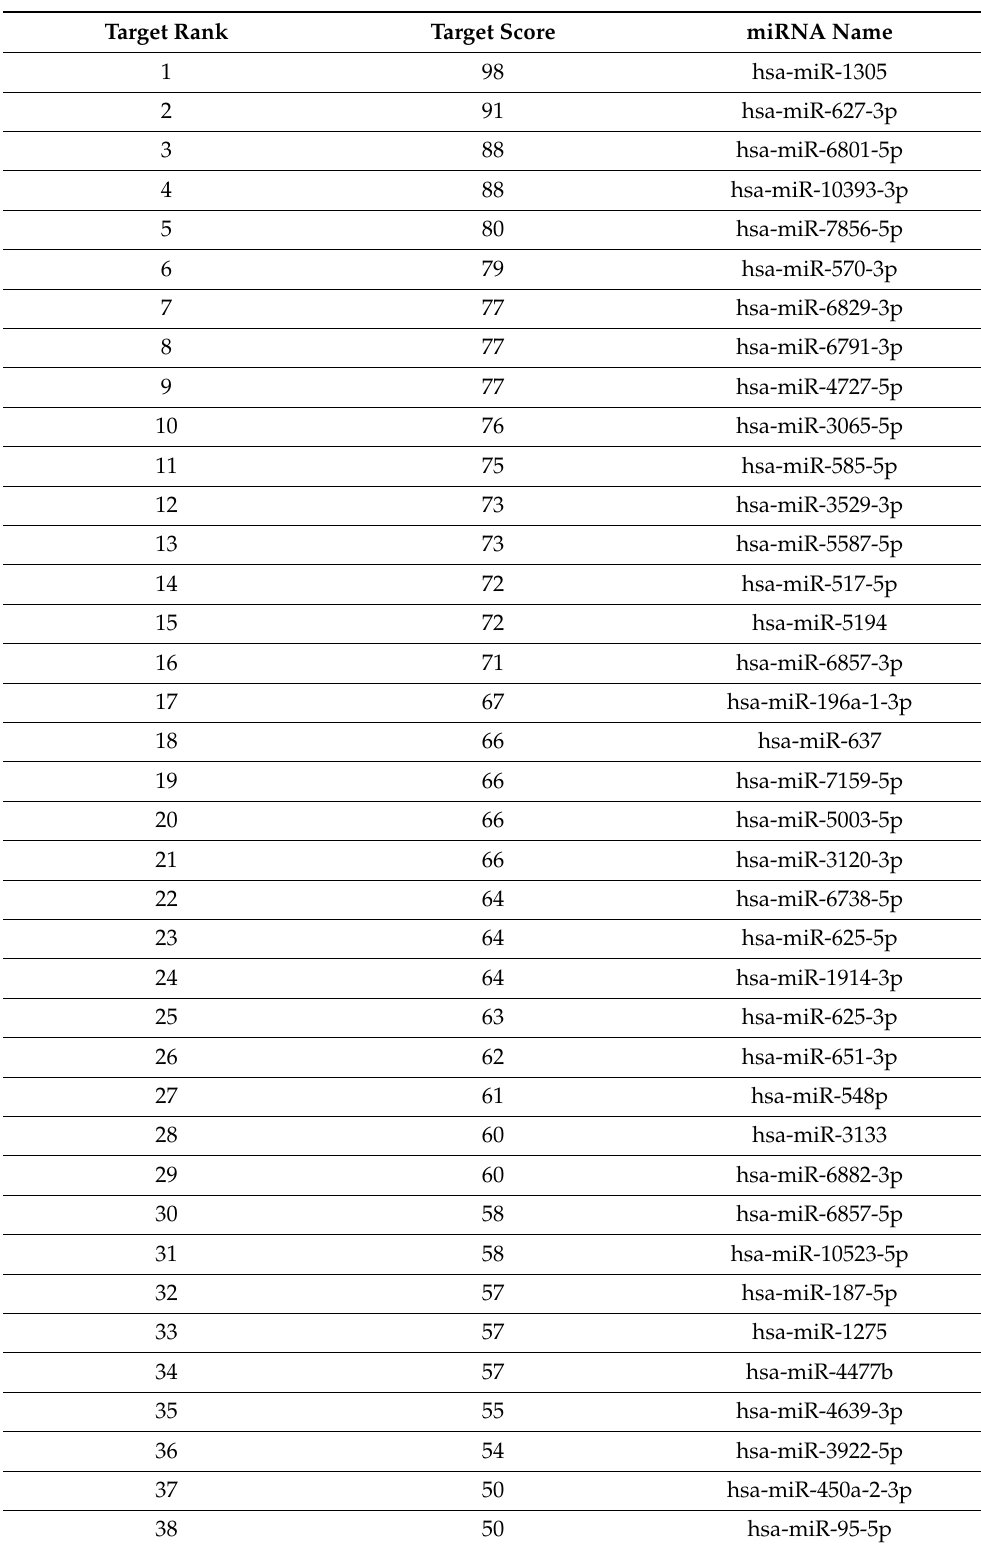
Table 3. RAP1 as a potential target for miRNAs accessed at miRDB (http://mirdb.org, accessed on 15 September